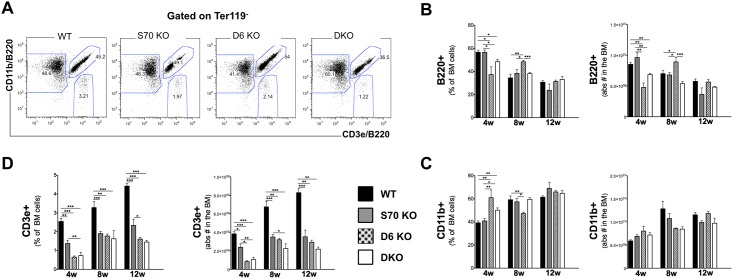
B-lymphocyte (B220+), T-lymphocyte (CD3e+) and myeloid (CD11b+) cell analysis in the bone marrow of Swap-70-/-, DEF6-/- and DKO mice.(A) Representative FACS plots of freshly isolated BM from wt, Swap-70-/- (S70 KO), DEF6-/- (D6 KO) and Swap-70-/-DEF6-/- (DKO) 8-week old mice. Total BM was subgated to discriminate B-lymphocytes (B220+), T-lymphocytes (CD3e+) and myeloid (CD11b+) cells. (B) Relative (on the left) and absolute (on the right) B220+ cell numbers in the BM of wt (black bars), SWAP-70 (grey bars) and DEF6 (dotted bars) single and DKO mice (white bars) of different ages (4, 8 and 12 weeks old) quantified by FACS. (C) Relative (on the left) and absolute (on the right) CD11b+ cell numbers in the BM of wt, SWAP-70 and DEF6 single and double knock-out mice of different ages quantified by FACS. (D) Relative (on the left) and absolute (on the right) CD3e+ cell numbers in the BM of wt (black bars), SWAP-70 (grey bars) and DEF6 (dotted bars) single and DKO (white bars) of different ages (4, 8 and 12 weeks old) quantified by FACS. At least 4 mice of each genotype per group were analyzed, in many instances >10 mice were analyzed. Mean ± SD. *P<0.05, **P<0.01, ***P<0.005.